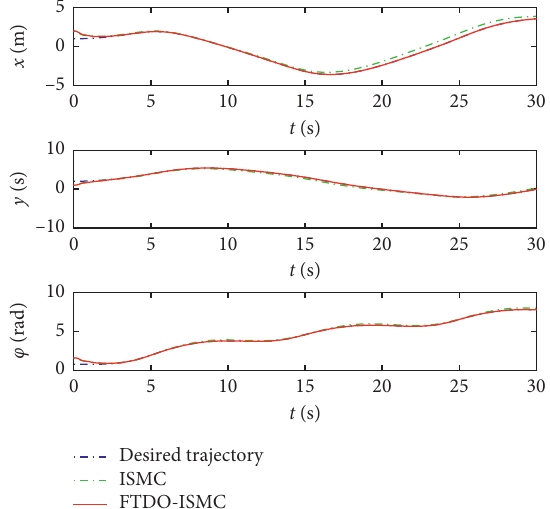
Figure 8: Position tracking on ISMC and FTDO-ISMC.